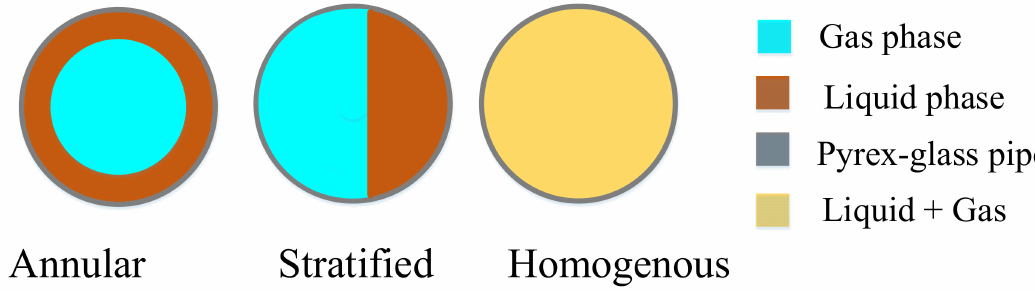
Figure 4. Simulated flow regimes.